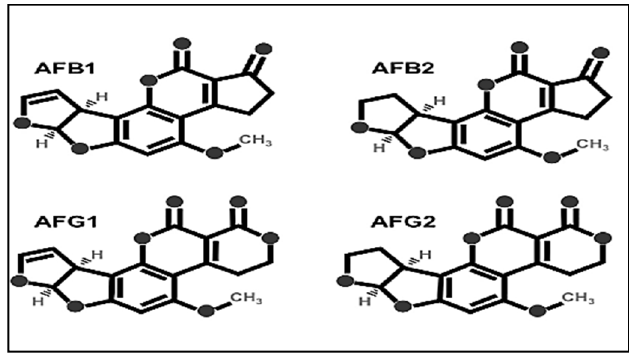
Figure 1. Chemical structures of AFB 1 , AFB 2 , AFG 1 , and AFG 2 .